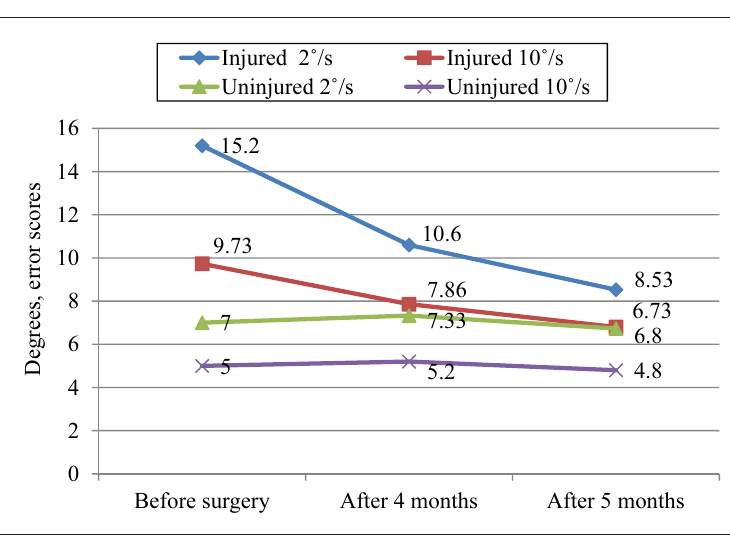
Figure 2. Mean values of uninjured and injured knee flexion at different velocities (p < 0.05)